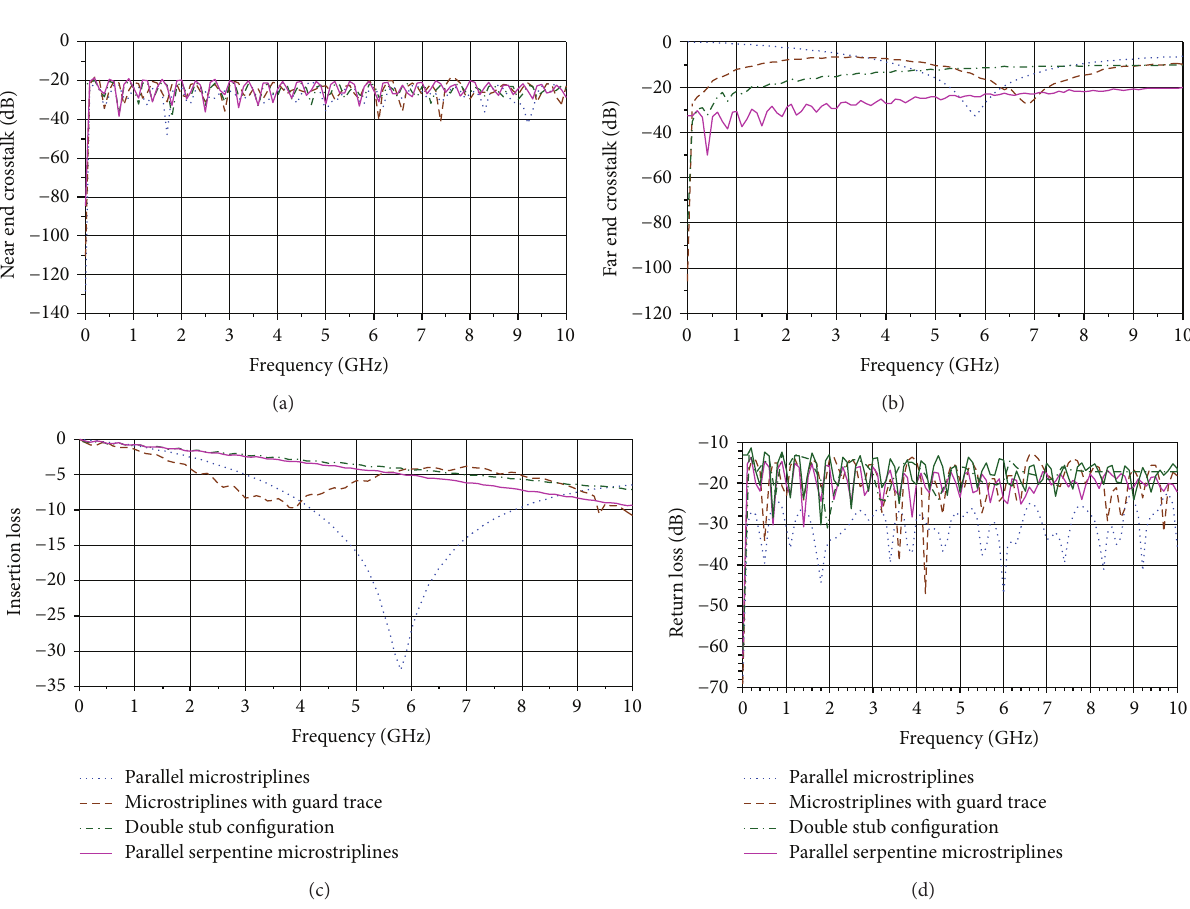
along the length direction is not larger than that of the parallel microstriplines. The effects of discontinuities of each